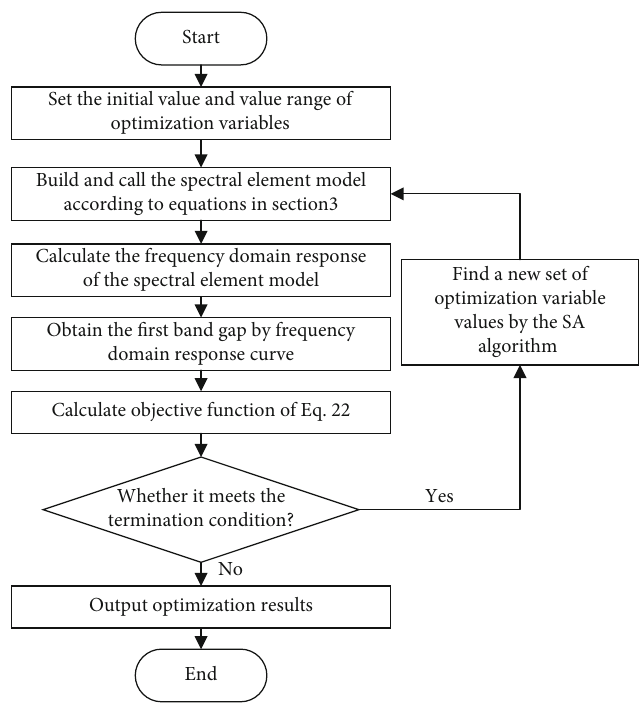
Figure 15: Optimization algorithm fl ow